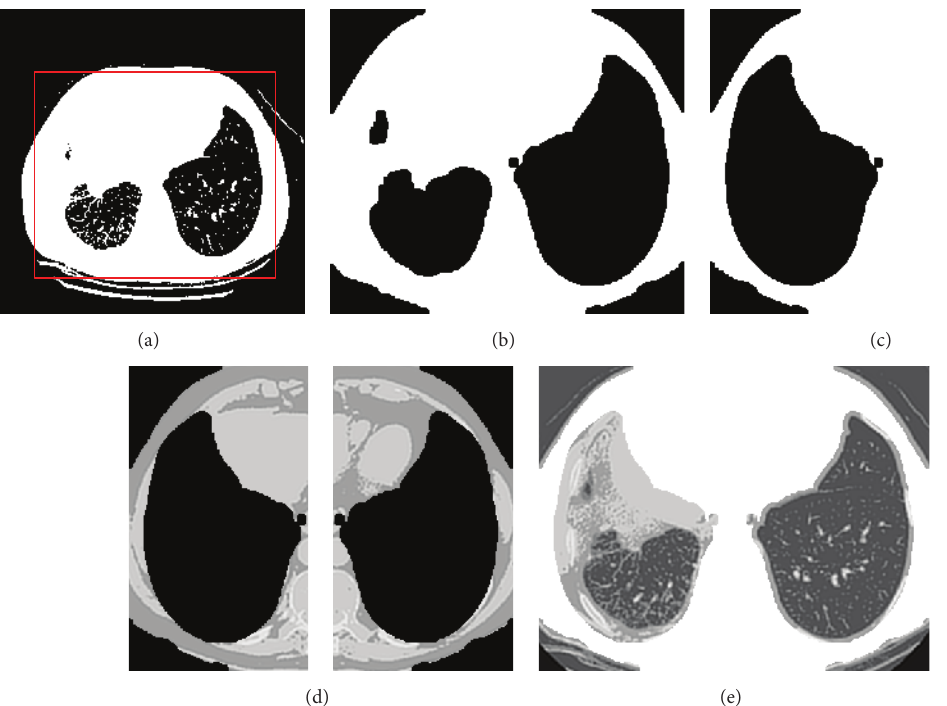
Figure 2: (a) The threshold image; (b) the eroded image; (c) the lung mask mirror; (d) the mask projection of the corresponding lungs images; (e) the extracted